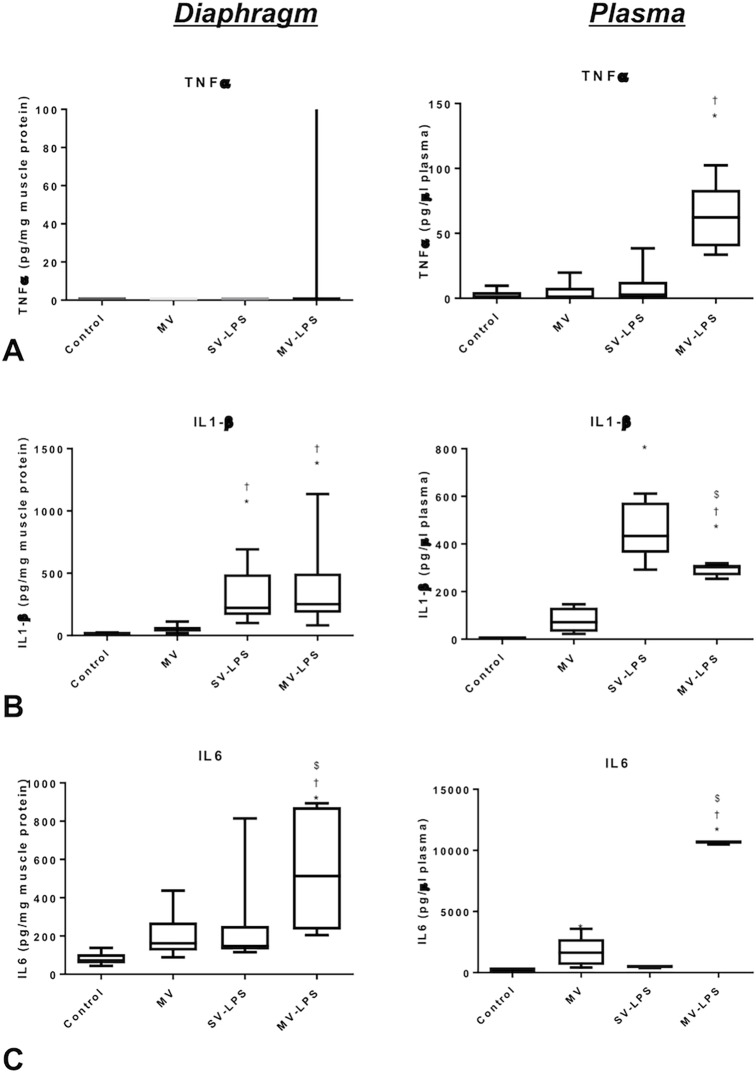
Tumor necrosis factor (TNF)-α (Panel A), interleukin (IL)-1β (Panel B) and IL-6 (Panel C) protein concentration in the diaphragm (left panels) and in the plasma (right panels) in the four experimental groups. Control = spontaneous ventilation without endotoxemia; MV = mechanical ventilation without sepsis; SV-LPS = endotoxemia with spontaneous ventilation; MV-LPS = endotoxemia with mechanical ventilation. Results are presented in the form of box plots as well as individual values. Boxes are drawn between the first and third quartiles of the distribution, black bars indicate the median, and whiskers indicate the minimum and maximum values, n = 8 per group. *: P<0.05 versus Control; †: P<0.05 versus MV; $: P< 0.05 versus SV-LPS.